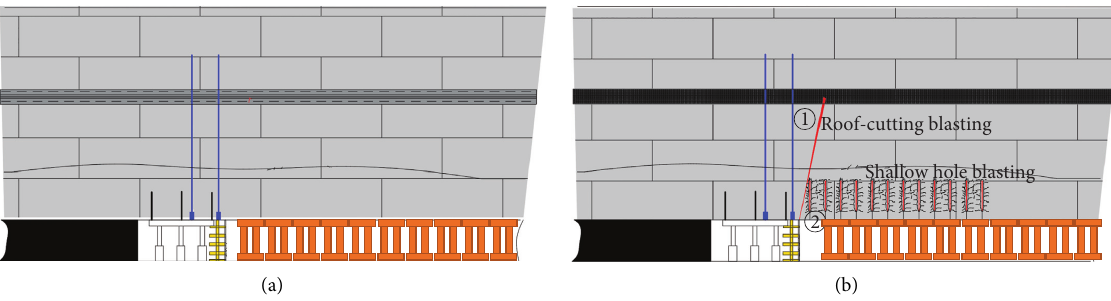
Figure 2: Comparison of two nonpillar mining methods. (a) No integrated presplitting blasting technology is used, the thick and hard roof structure will cause the roof cantilever to be larger, and the roof often fails to collapse in time after mining, which causes greater safety hazards to the roadway. (b) Integrated presplitting blasting technology is used, which will weaken the strength of the roof and reduce the span of the roof and the pressure when it collapses.